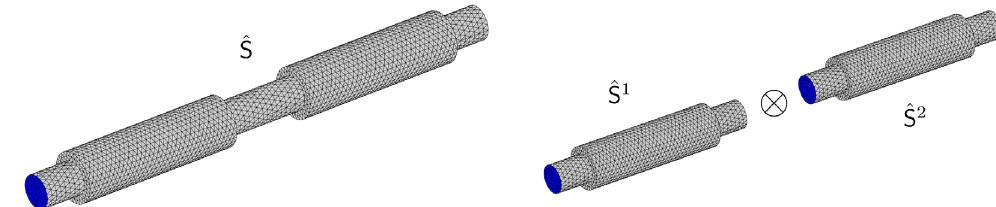
Figure 7. Illustration of an acoustic system with two ports (the FE mesh is represented). Scenario 1 (left) is referred to as “ Monobloc ” (in this example the length of the central duct is 10 cm) and scenario 2 (right) is referred to as “ Chained ” . Note the entrance of the system is identi fi ed by the blue color.